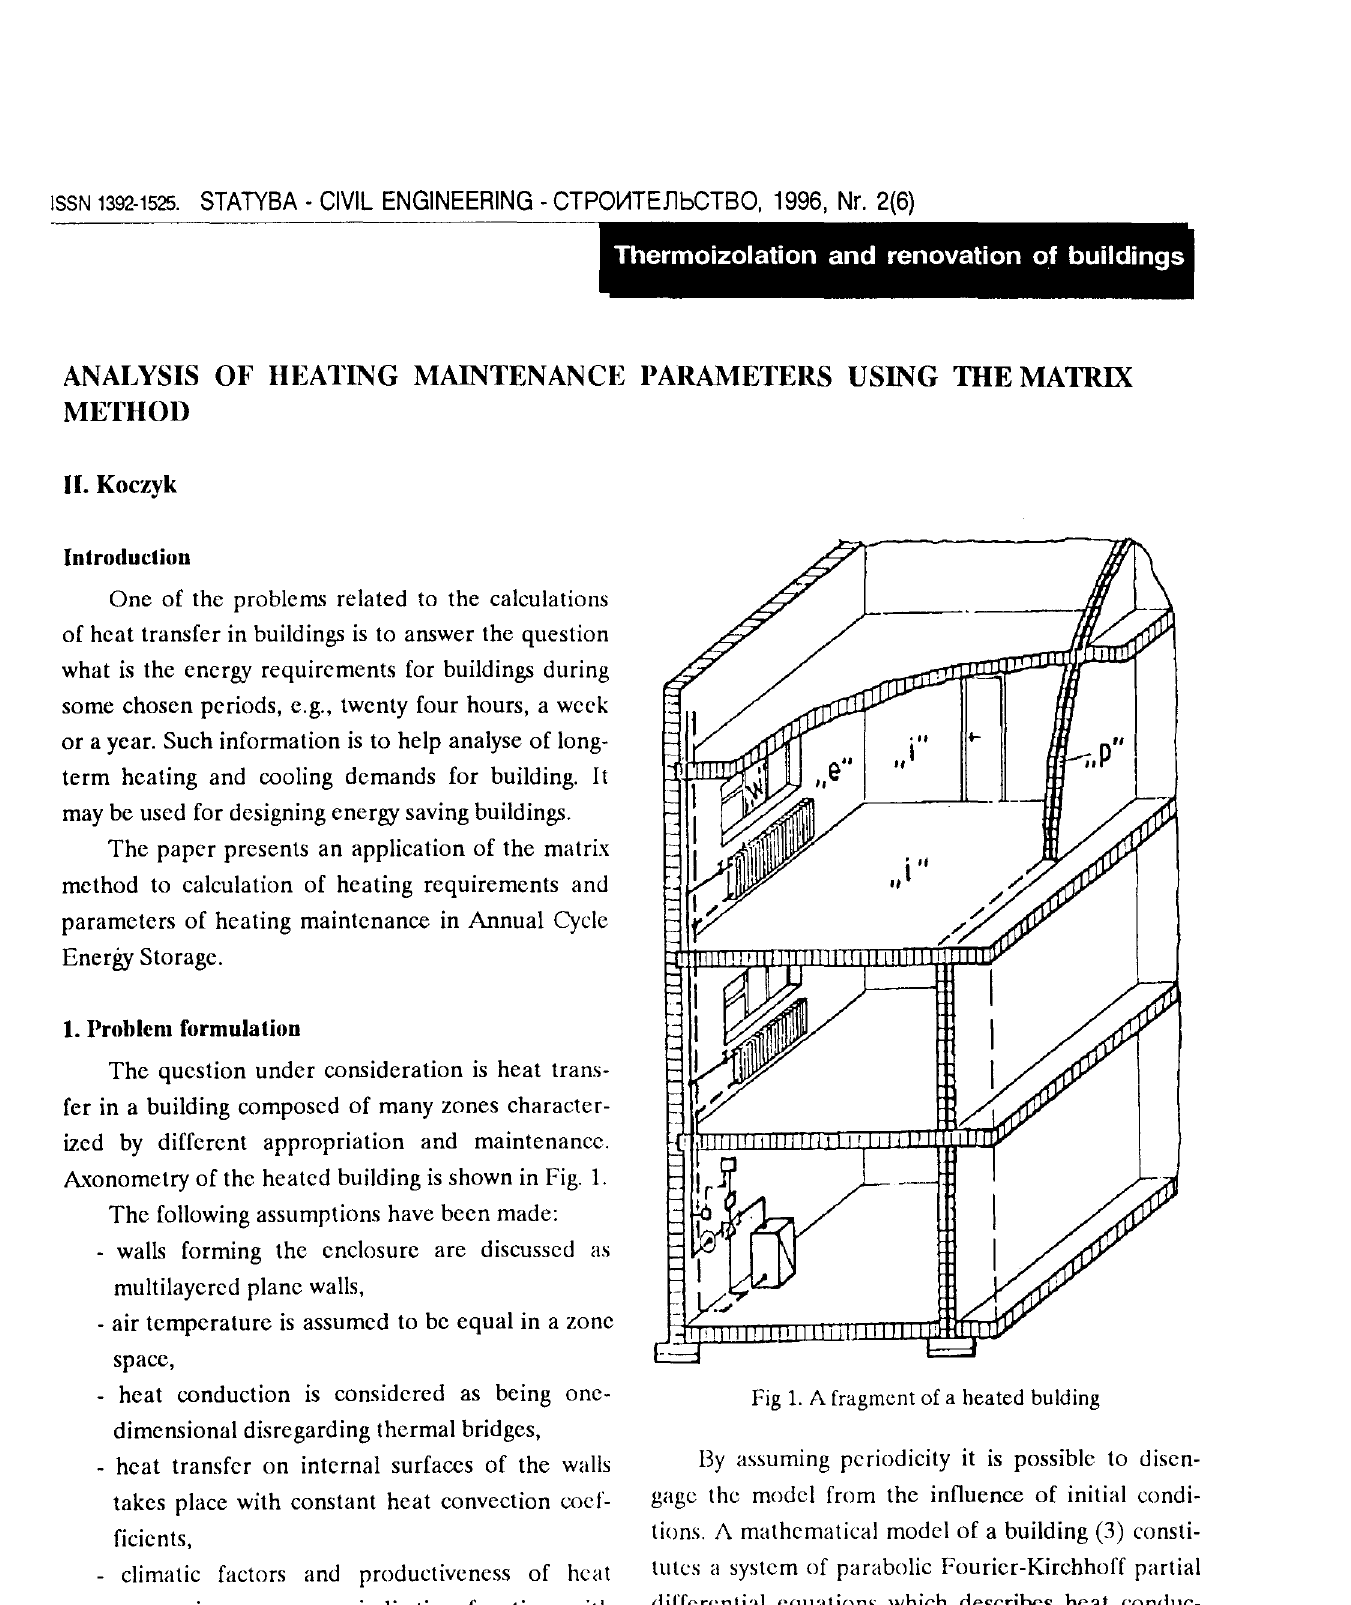
Fig 1. A fragment of a heated bulding By assuming periodicity it is possible to disen gage the model from the influence of initial condi tions. A mathematical model of a building (3) consti tutes a system of parabolic Fouricr-Kirchhoff partial differential equations which describes heat conduc tion in material layers, equations of heat balance of the air for each zone and equations describing heat transfer in radiator cycle for each zone. System